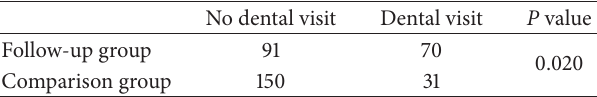
Table 3: Chi-square analysis of dental utilization in the study group at followup and the comparison